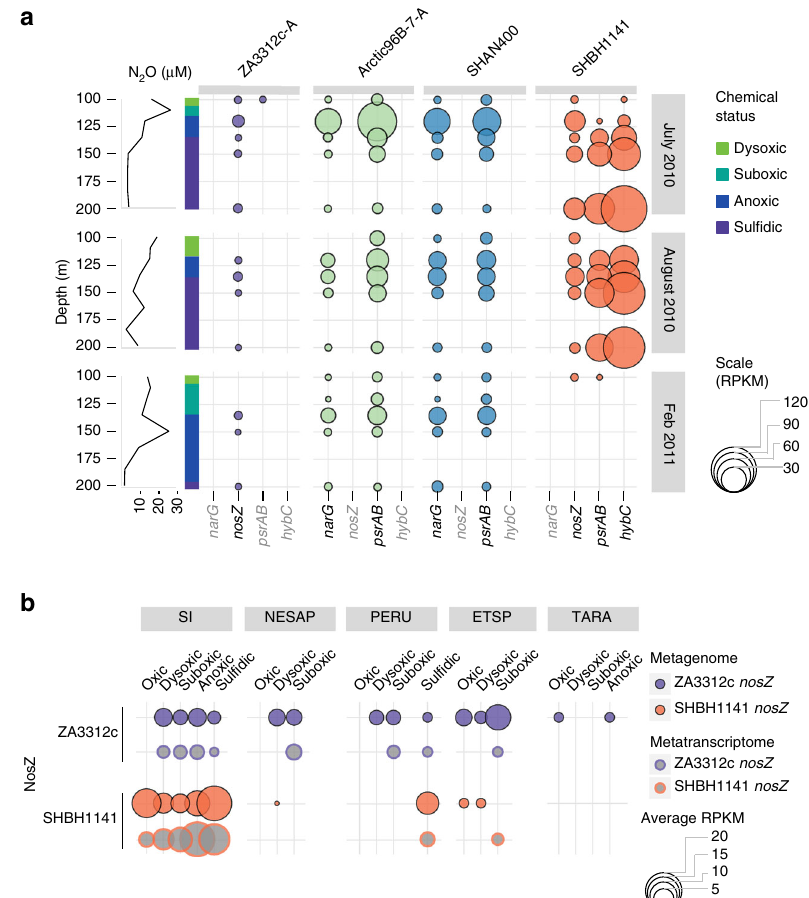
Fig. 4 Expression of selected Marinimicrobia energy metabolism genes. a Expression of selected genes involved in Marinimicrobia energy metabolism in Saanich Inlet station SI03 at three time points and fi ve depths between 100 and 200 m. Size of circle represents reads per kilobase per million mapped (RPKM) 52 for metatranscriptomic reads mapped to the selected genes for the indicated population genomes. Water column redox state for each time point encoded on left axis and nitrous oxide concentration pro fi le for each time point on left. Enzymes: nitrate reductase ( narG ), Nitrous oxide reductase ( nosZ ), polysul fi de reductase subunits A and B ( psrAB ) and Ni-Fe hydrogenase subunits A and B ( hybC ). b Detected genes and transcripts for Marinimicrobia ZA3312c and SHBH1141 nosZ along eco-thermodynamic gradients from oxic ( > 90 µ mol O 2 ), dysoxic (20 – 90 µ mol O 2 ), suboxic (1 – 20 µ mol O 2 ), anoxic ( < 2 µ mol O 2 ), and sul fi dic conditions in Saanich Inlet (SI) time series, Northeastern Subarctic Paci fi c (NESAP), Peru, Eastern Tropical South Paci fi c (ETSP), and TARA Oceans (no transcriptomes available) data sets. For SI and ETSP dot size represents average reads per killobase per million mapped (RPKM) summed for a given nosZ type for each metagenome or metatranscriptome and averaged by the total number of metagenomes or metatranscriptomes for a given water column classi fi cation. For ETSP, Peru, and TARA bubble size is the number of reads (ETSP and Peru) or contigs (TARA) with nosZ averaged per number of metagenome or metatranscriptomes for a given water column classi fi